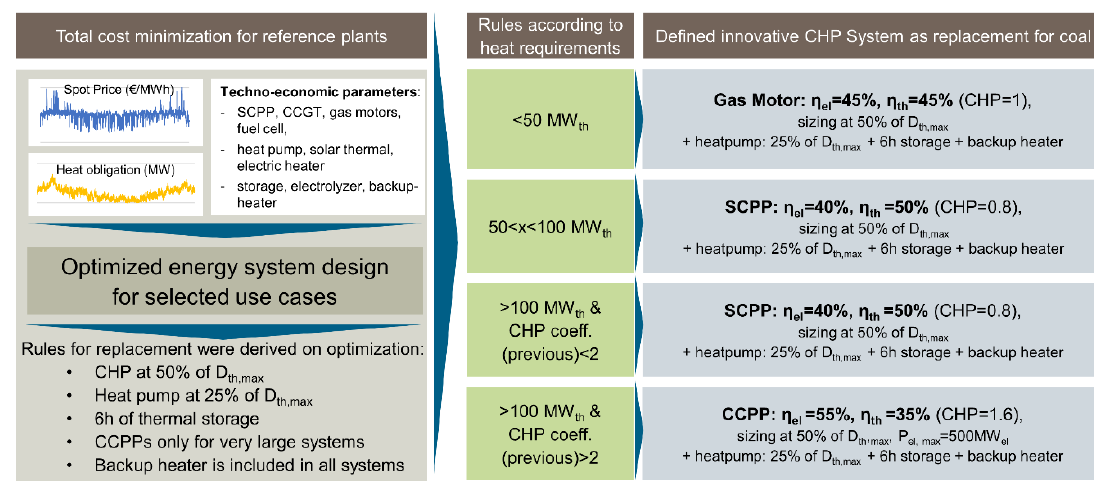
Figure 4. Optimization of components for innovative CHP systems and derivation of a rule-based replacement of all heat sinks left after coal exit. The figure on the left shows the method to derive cost-optimal CHP configurations by using timeseries of heat demand and electricity prices, as well as techno-economic parameters of the available technologies. The derived rules are depicted on the right and show the technology configuration depending on the heat requirements of the system to be replaced by innovative CHP.